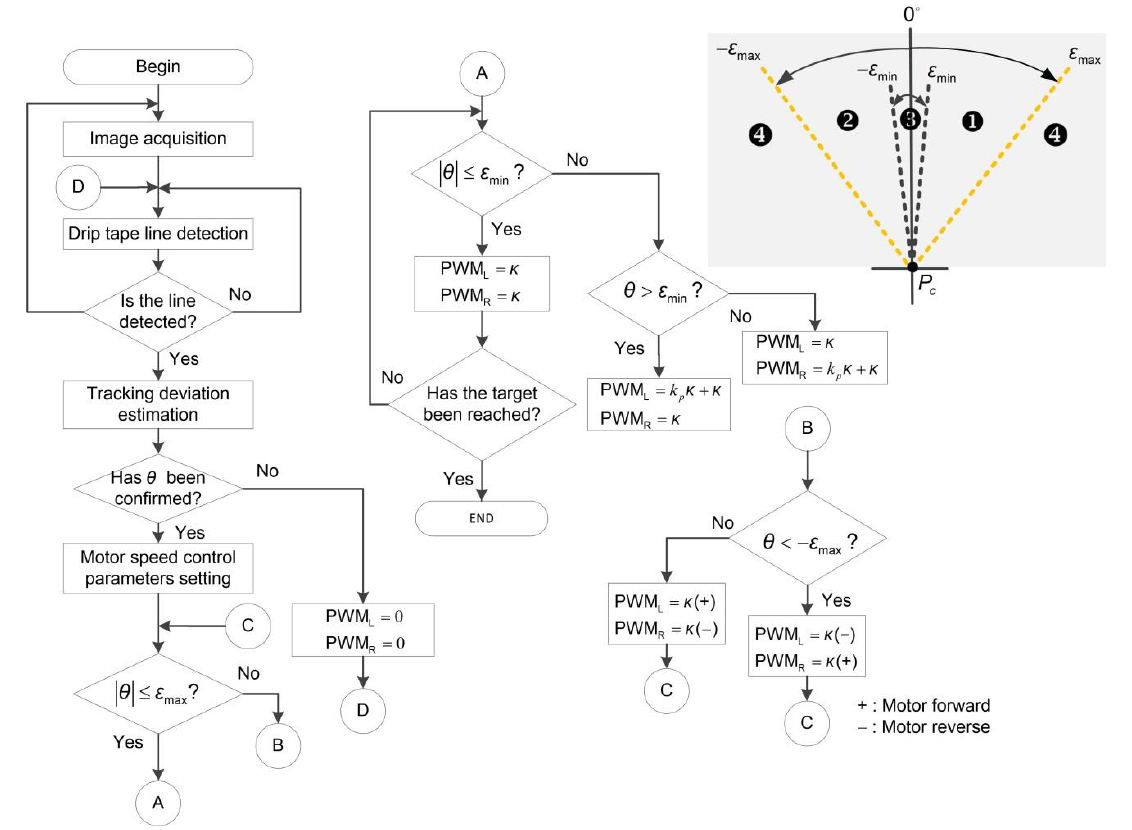
Figure 9. Line of drip tape detection and steering control process. The numbers “ (cid:182) ”, “ (cid:183) ”, “ (cid:184) ” and “ (cid:185) ” respectively demonstrated the areas corresponding to the heading of the robot; the letters A, B, C, D inside the circle represented flowchart connectors.